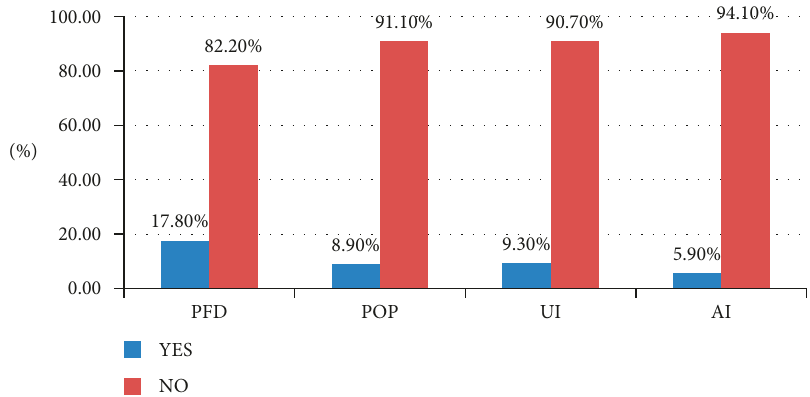
Figure 1: A chart showing overall PFD in Wolkite University specialized center, Ethiopia, June to July